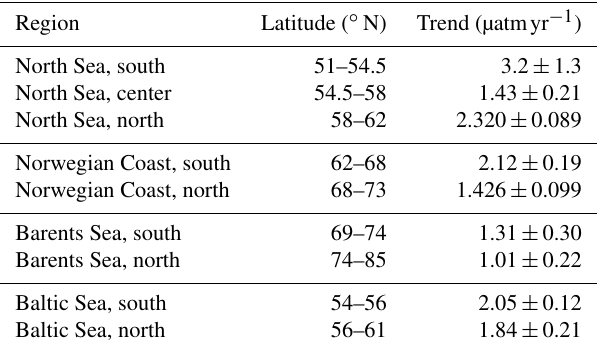
Table 6. f CO 2 trend calculated from gridded, deseasonalized SO- CAT v5